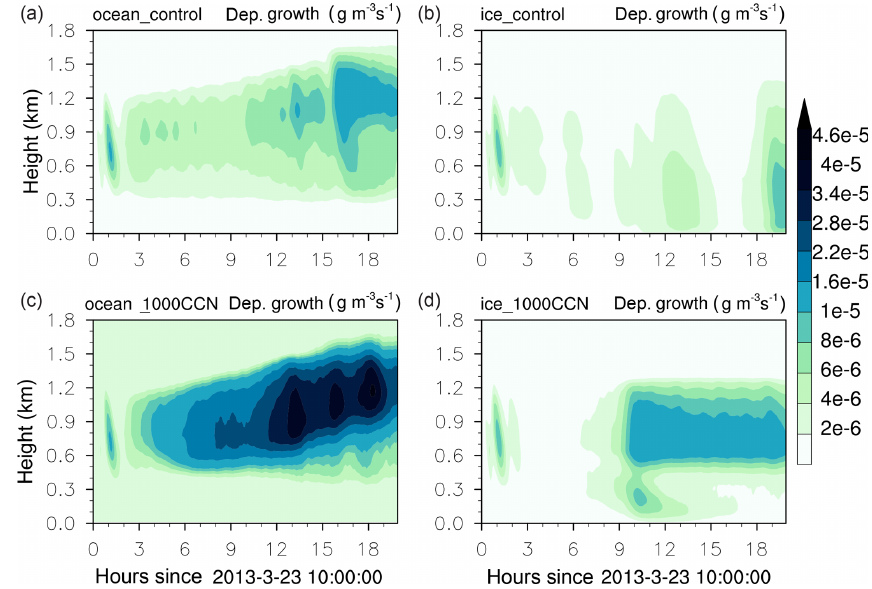
Figure 6. Domain-averaged depositional growth rate for the (a) ocean_control and (b) ice_control simulations and (c, d) the respective 1000CCN simulations. Note the nonlinear color bar.